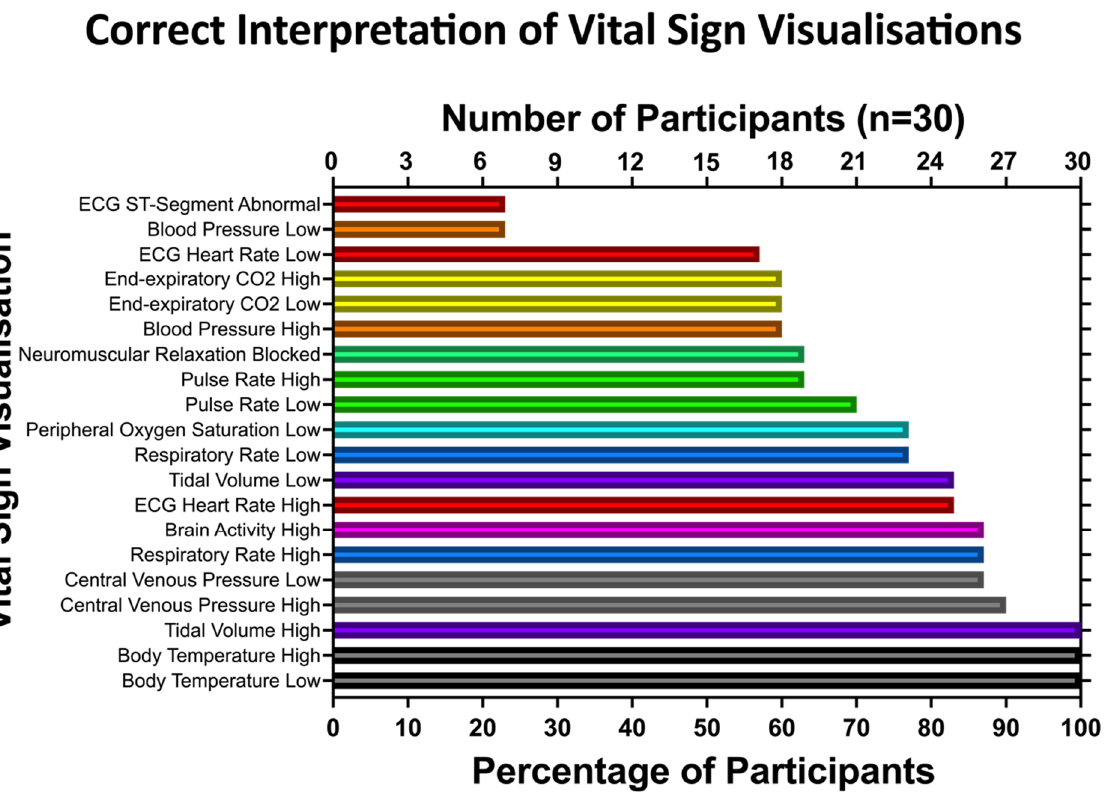
Figure 5. Intuitive interpretation accuracy per vital sign deviation. The correct interpretations are given as answer count and percentages. A maximum of 30 out of 30 (100%) interpretations per vital signs were correct.